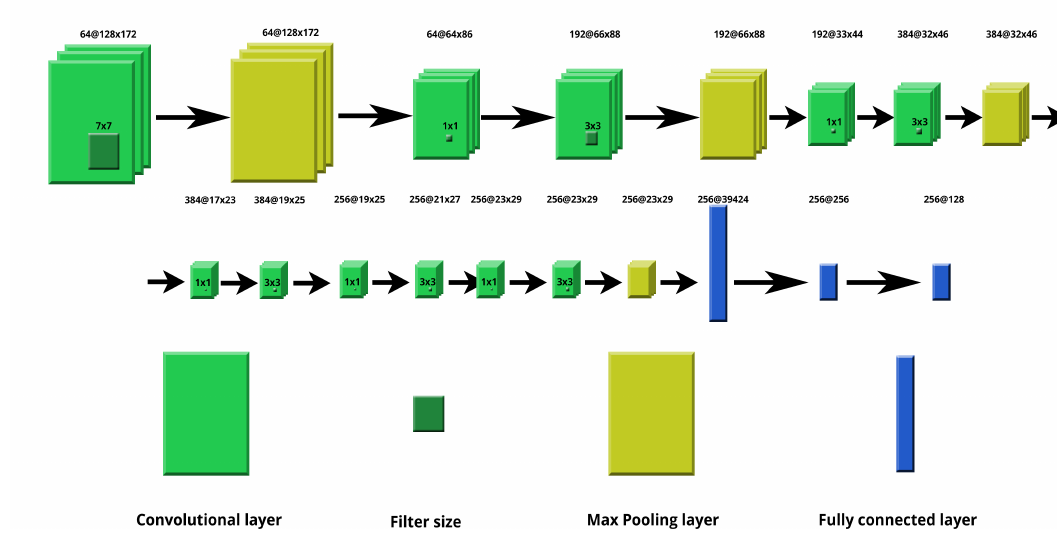
Figure 4. Neural network